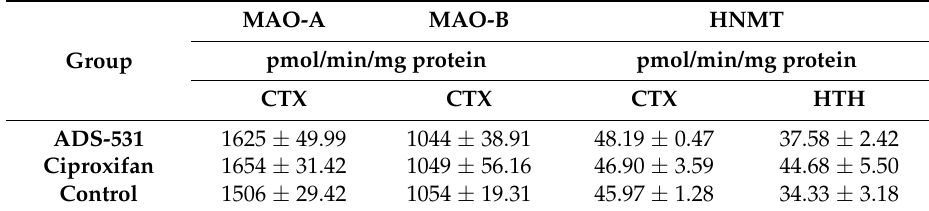
Table 2. The effect of subchronic administration of ADS-531 (s.c. 3 mg/kg/daily for five days) or